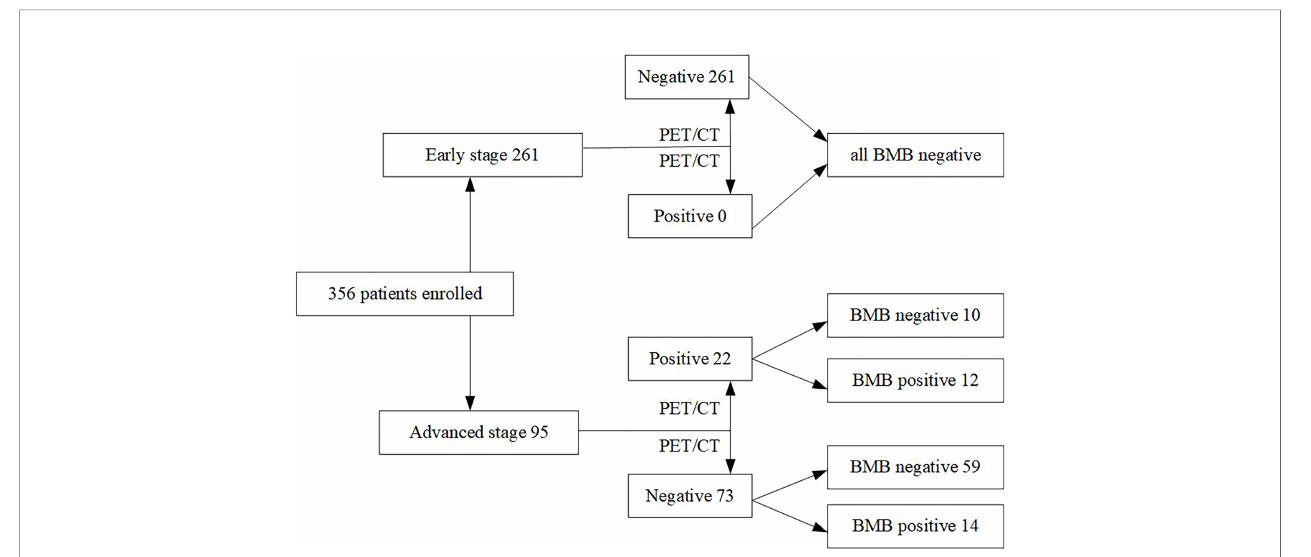
FIGURE 1 | The distribution of bone marrow status as assessed with PET/CT and bone marrow biopsy ENKTL